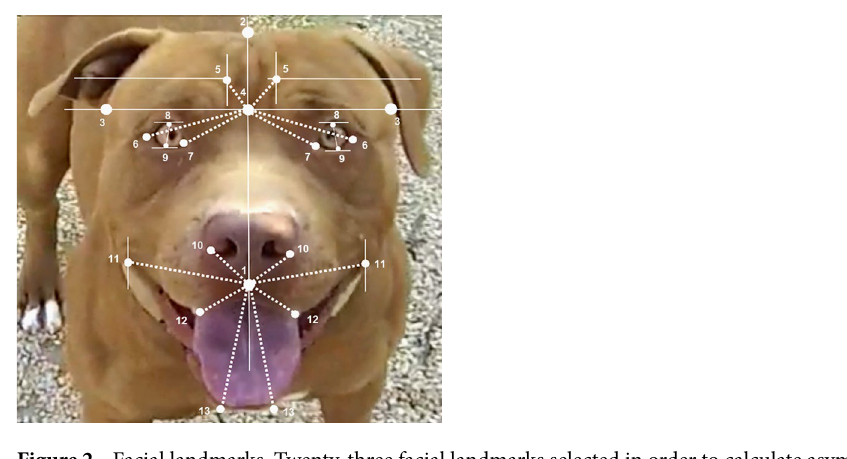
Figure 2. Facial landmarks. Twenty-three facial landmarks selected in order to calculate asymmetrical face ratio